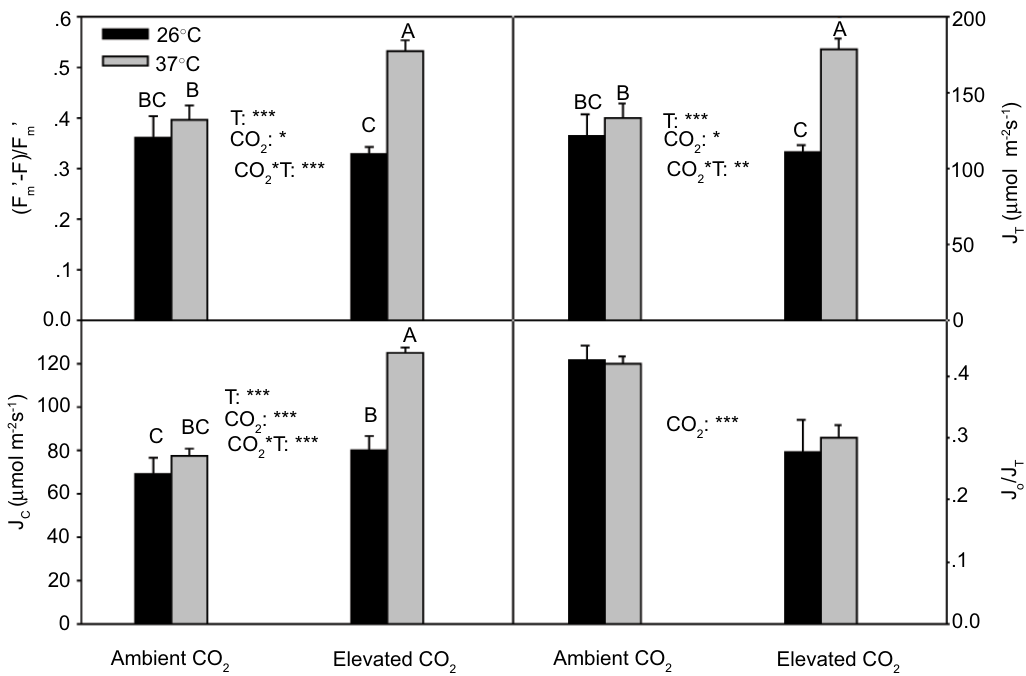
Figure 4. (F fluorescence measurements, and J Figure 2 for other